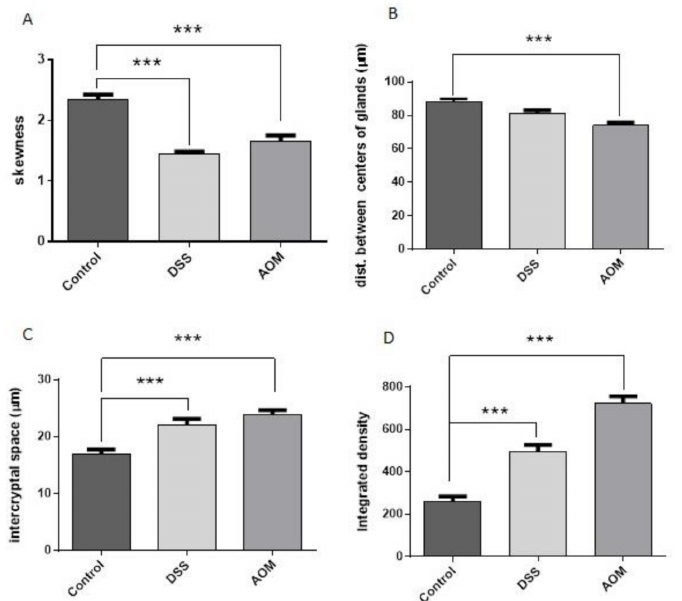
Figure 5. Evaluation of collagen distribution and colon tissue structures. In comparison to the control, the skewness variation ( A ) was significant in both DSS and AOM groups; the distance between centres of the crypts ( B ) was significant after AOM, while the inter-cryptal space wideness ( C ) was significant in both DSS- and AOM-treated groups. The integrated density ( D ) showed significant differences from the control and between the groups at p < 0.001. Significance by Kruskal–Wallis test: *** p < 0.001 in comparison to the untreated